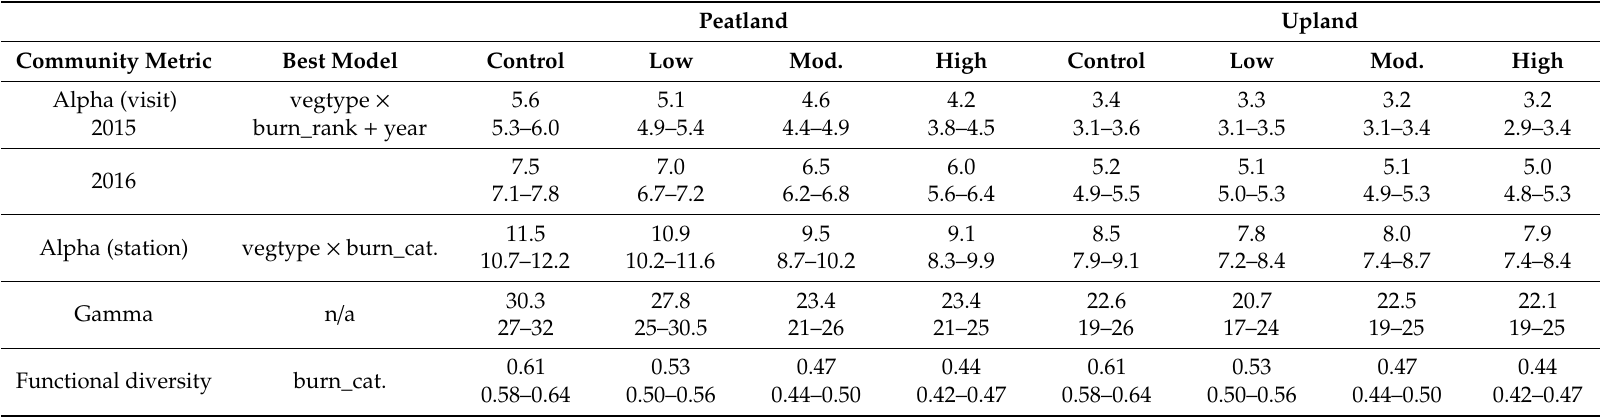
Table 2. Mean species richness ( ± 95% C.I.) across vegetation types and burn severity in each year (Alpha visits 2015 and 2016), with years combined (Alpha (station)), Gamma diversity, and functional diversity. Results are shown as means and 95% confidence intervals. Mod. =